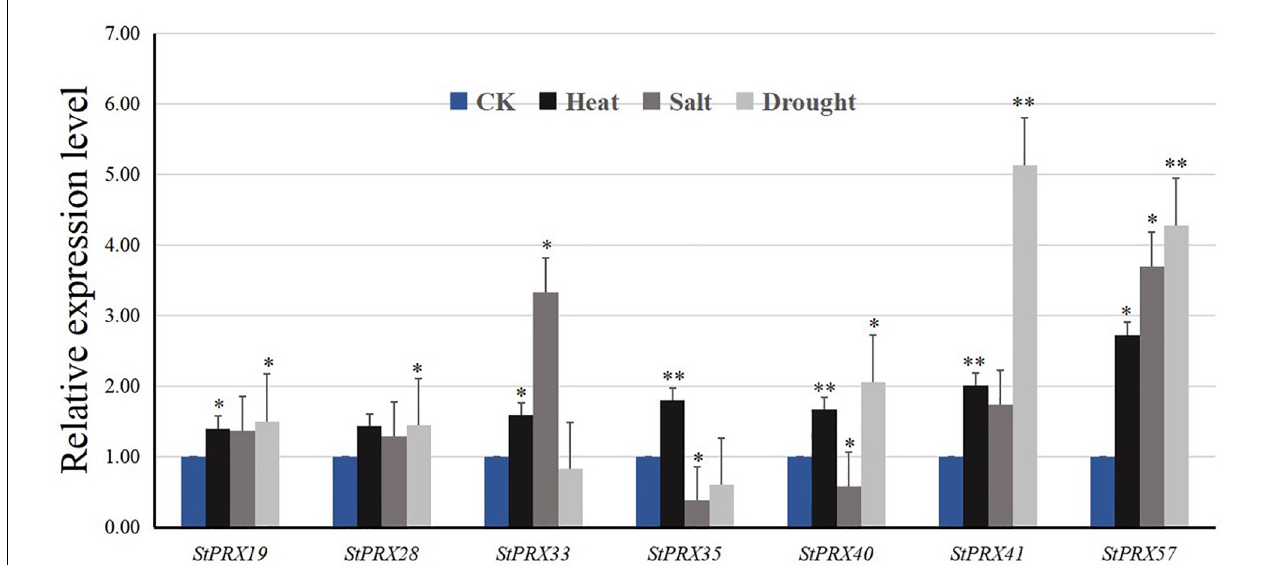
FIGURE 7 | Relative expression levels of 7 StPRX genes in response to heat, salt and drought stresses after 6 h treatment compared with that of control (CK). Error bars are standard deviations of three biological replicates. * P < 0.05, ** P <